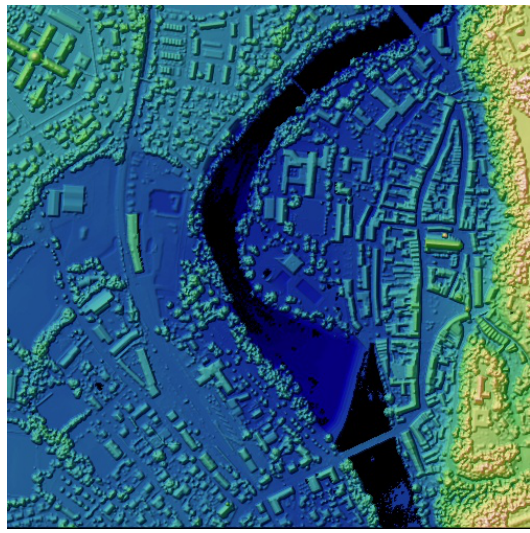
Figure 5. LiDAR Reference DSM used during evaluation.